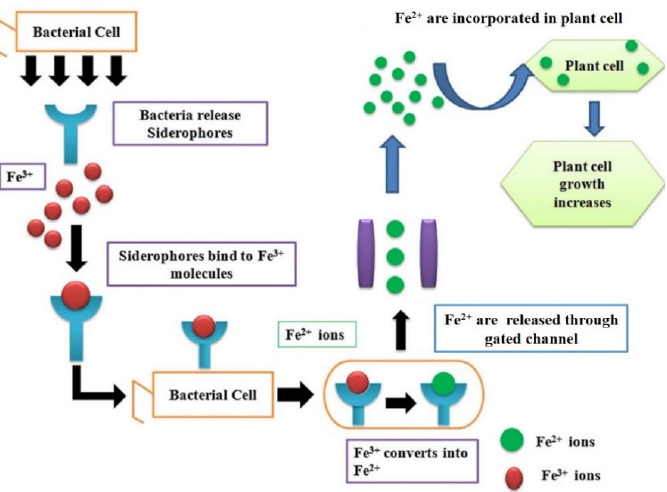
Figure 4. Plant growth-promoting rhizobacteria produce siderophores, which are used to sequester iron. Bacteria release low-molecular-weight iron chelators known as “siderophores,” which have high affinity for Fe 3+ , bind firmly to it, and are taken up by bacteria. Fe 3+ is converted to Fe 2+ inside the bacterial membrane, and Fe 2+ is discharged into the cell via a gated channel that connects the bacteria’s inner and outer membranes. The total plant growth improves significantly when the host plant integrates these soluble Fe 2+ molecules produced by the